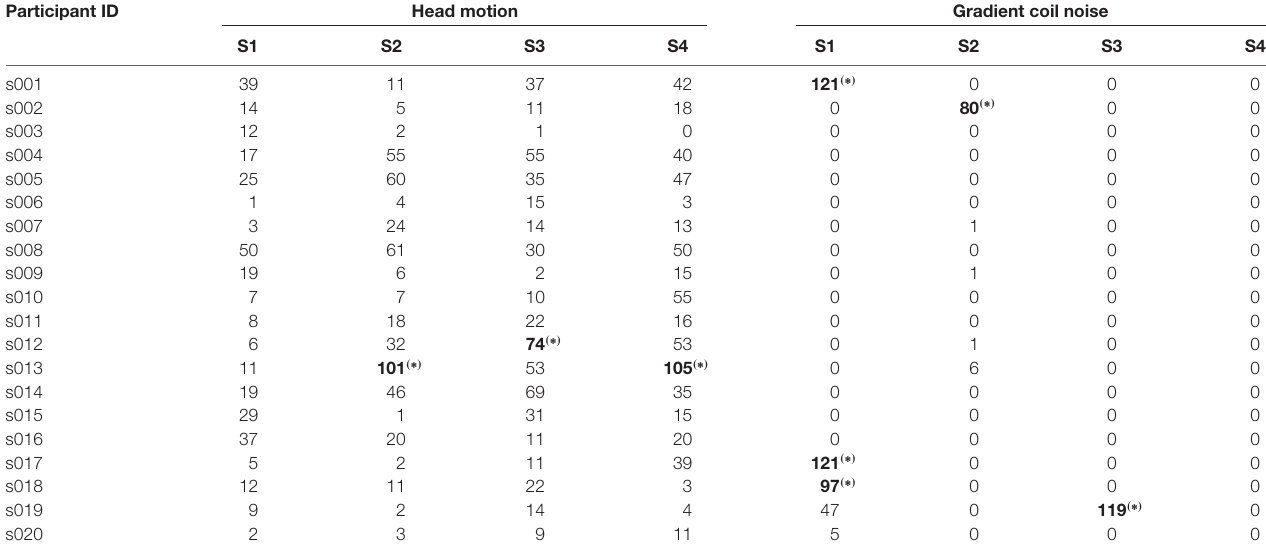
TABLE 1 | Number of resting state functional magnetic resonance imaging (fMRI) volumes censored due to head motion (mean FD > 0.2) and gradient coil noise (threshold = 3). Participant ID